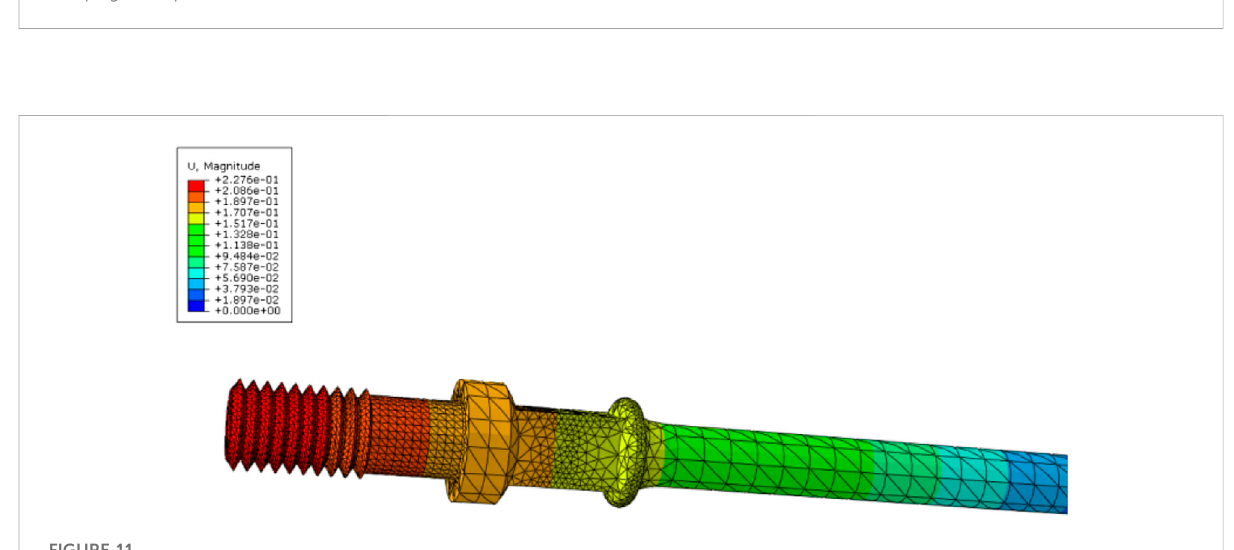
FIGURE 11 Pumping rod deformation